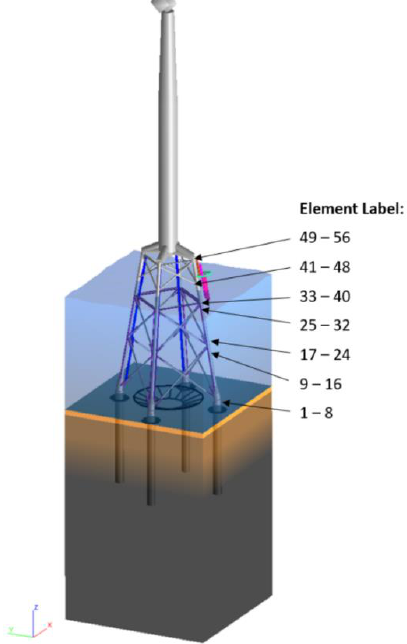
Figure 4. Representation of the structure in ROSA, including appurtenance, sea and soil. Labels of joints presented.